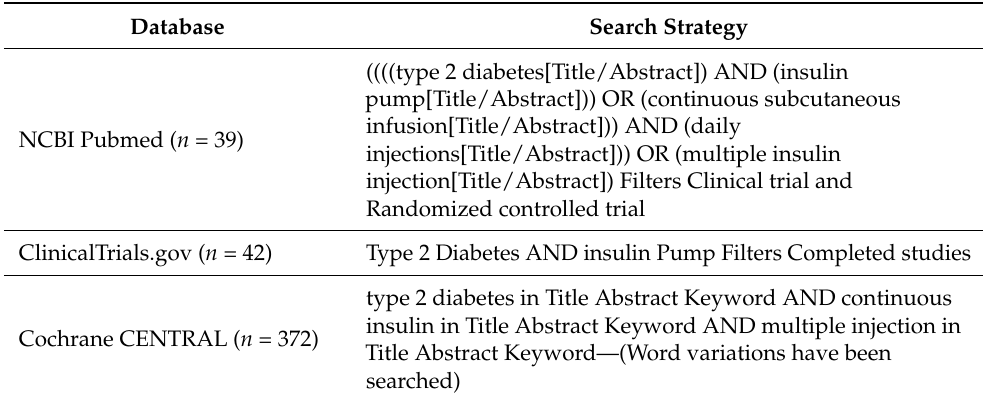
Table 1. Search strategy with the respective keywords used for the present analysis (numbers in parenthesis indicate the number of publications